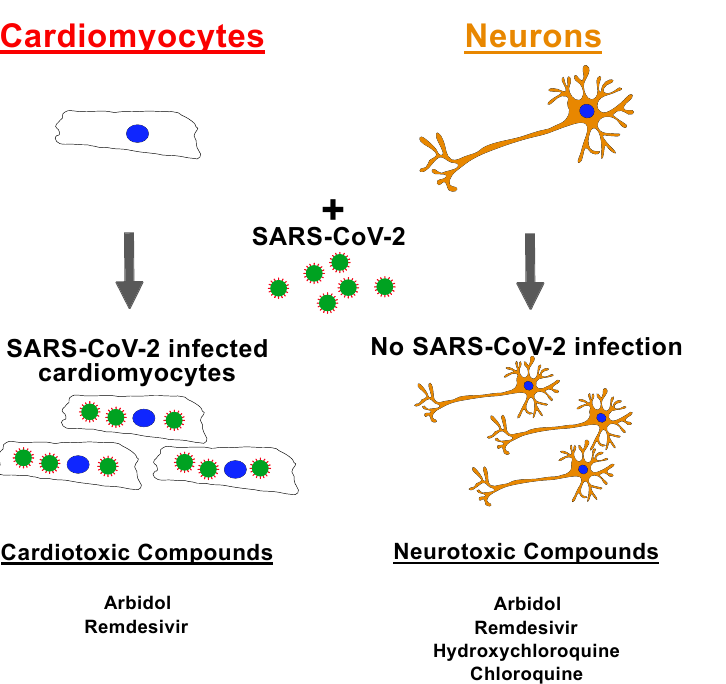
Figure 3. Overview of results showing that cardiomyocytes can be infected with SARS-CoV-2, but not neurons, and a list of cardiotoxic and neurotoxic anti-COVID-19 compounds. Limitations of Study